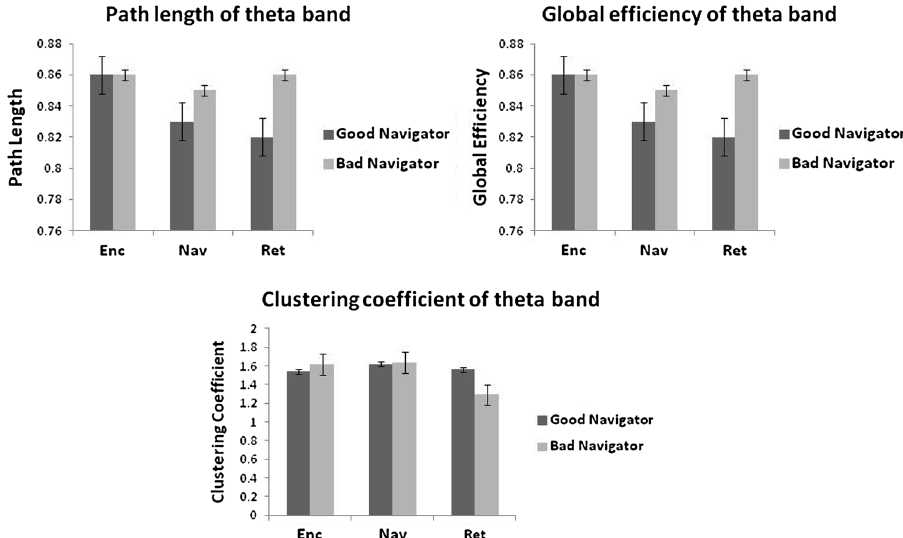
Fig. 2 Graph parameters for Theta (4–7 Hz) wave synchronisation during encoding (Enc) phase, navigation (Nav) phase and retrieval (Ret) phase of the task. Only clustering coefficient (CC) was found to be significant in Ret phase, p = 0.001